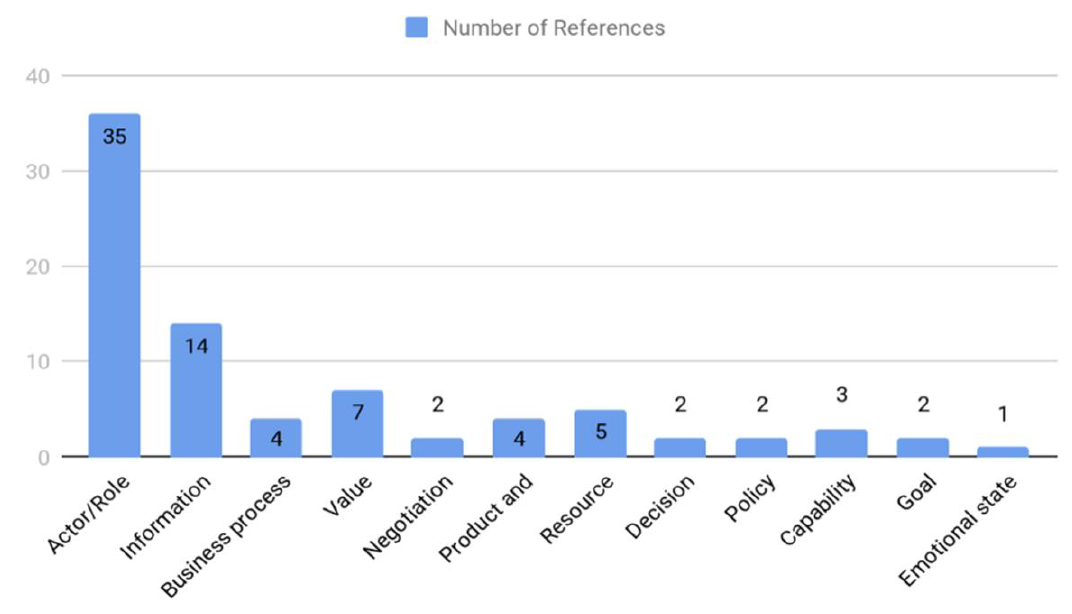
Figure 3. Numbers of studies for each of the DBE modeling